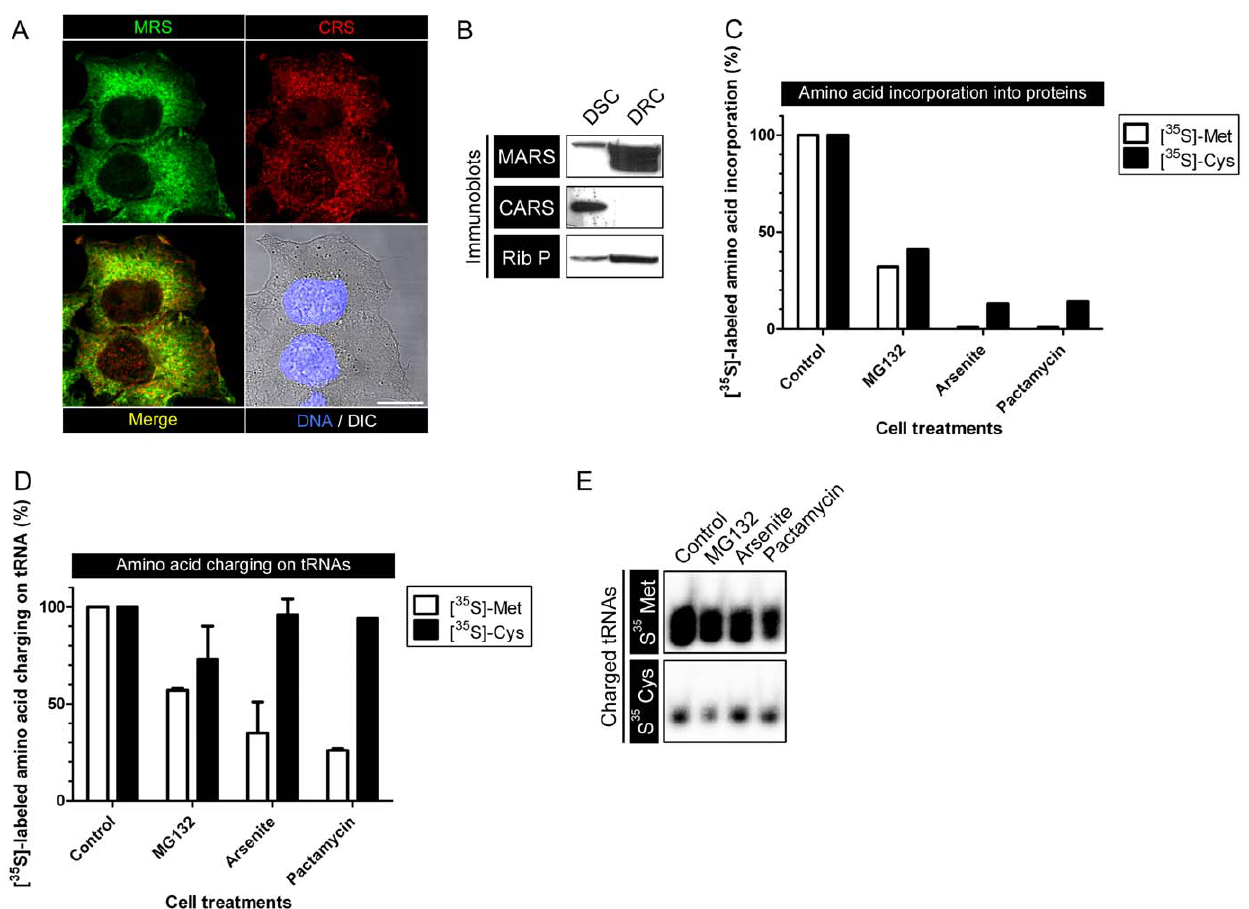
Figure 1. MRS and CRS define two distinct cytosolic compartments. A. Immunofluorescence staining of HeLa cells. MRS (green) and CRS (red) only partially co-localize. Bar scale: 10 m m. B. Immunoblot of sequential HeLa cells extractions. Cells were first extracted with digitonin (DSC: digitonin soluble compartment), then washed and extracted with NP-40 (DRC: digitonin resistant compartment). Membranes were blotted for MRS, CRS and ribosomal P proteins. C. HeLa cells were pre-treated for 2 h with MG132 or for 30 min with either arsenite or pactamycin. Then cells were labeled with [ 35 S]-Cys or [ 35 S]-Met. Half of each sample was used to extract total proteins and cpm were counted. 100% cpm was determined using untreated HeLa cells. For [ 35 S]-Met: 100%=982785 cpm. For [ 35 S]-Cys: 100%=371828 cpm. D. The other half of each sample from ‘‘C’’ was used. Total RNAs were extracted and cpm counted. 100% cpm was determined using untreated HeLa cells. For [ 35 S]-Met: 100%=288248 cpm. For [ 35 S]-Cys: 100%=69183 cpm. E. The same samples used in ‘‘D’’ were loaded on acid gels to visualize either [ 35 S]-Met-tRNAs or [ 35 S]-Cys-tRNAs. The two bands for [ 35 S]-Met-tRNAs correspond to the mitochondrial tRNA Met and the nuclear encoded tRNA Met .